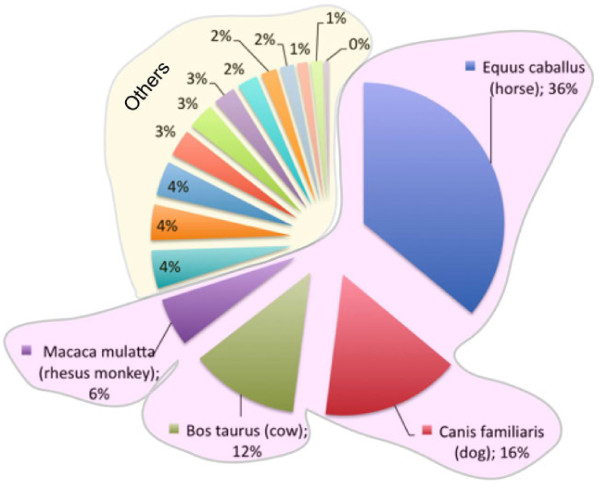
Bat transcripts are most closely related to horse genes. Summary of 183,788 hits from the thymus dataset to annotated genes from other species in the KEGG databases. Others from left to right in the pie chart include Homo sapiens (human), Pan troglodytes (chimpanzee), Sus scrofa (pig), Monodelphis domestica (opossum), Rattus norvegicus (rat), Mus musculus (mouse), Taeniopygia guttata (zebra finch), Ornithorhynchus anatinus, (platypus), Gallus gallus (chicken), Danio rerio (zebrafish), Xenopus tropicalis (western clawed frog), Xenopus laevis (African clawed frog).